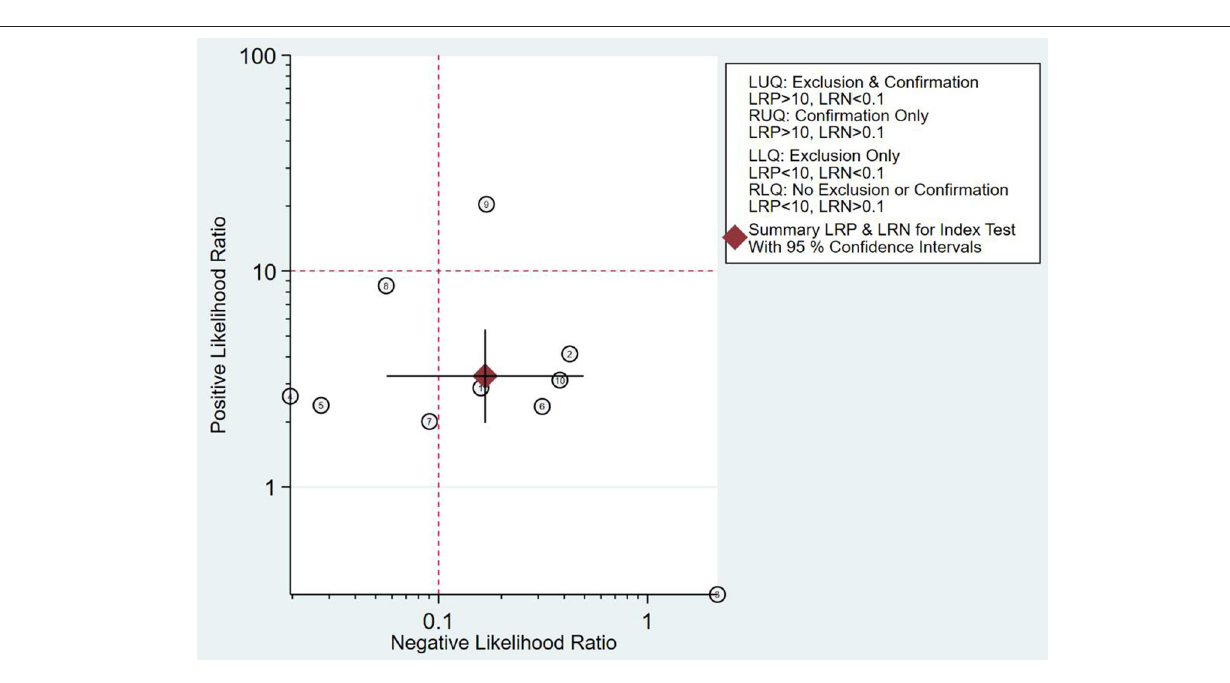
FIGURE 7 | Likelihood ratio dot